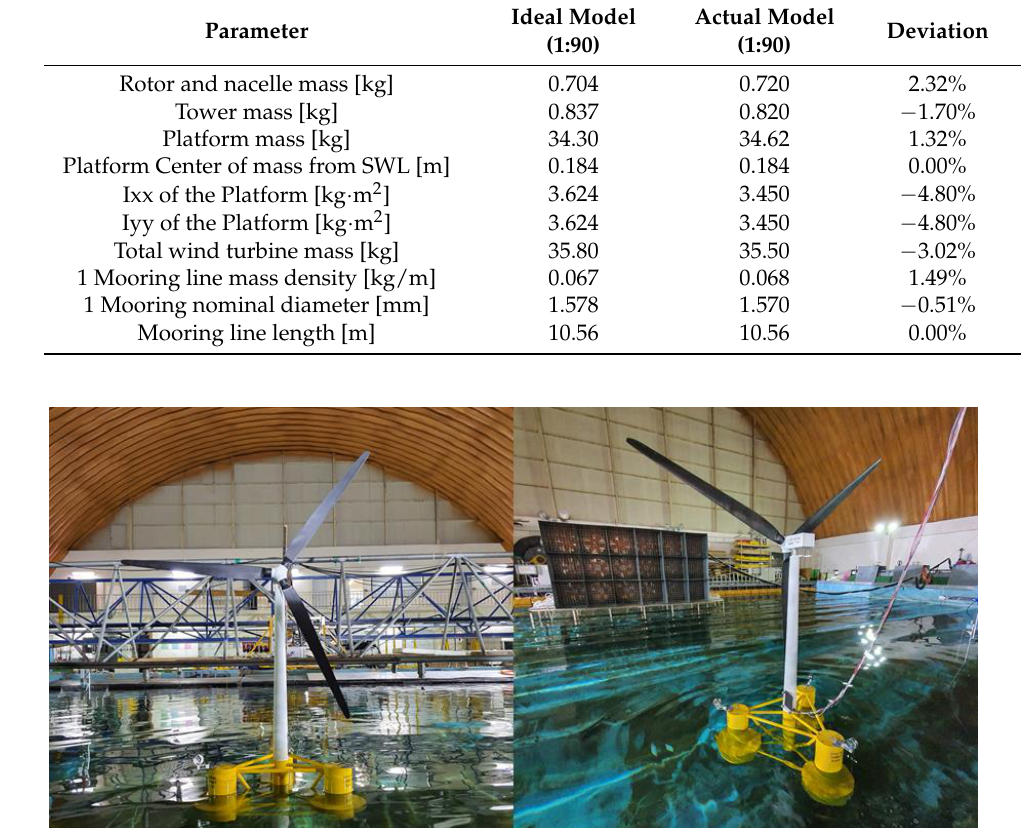
Figure 1. General arrangement of the 10 MW S-FOWT floating platform. Table 4. Deviation between ideal model and real model.